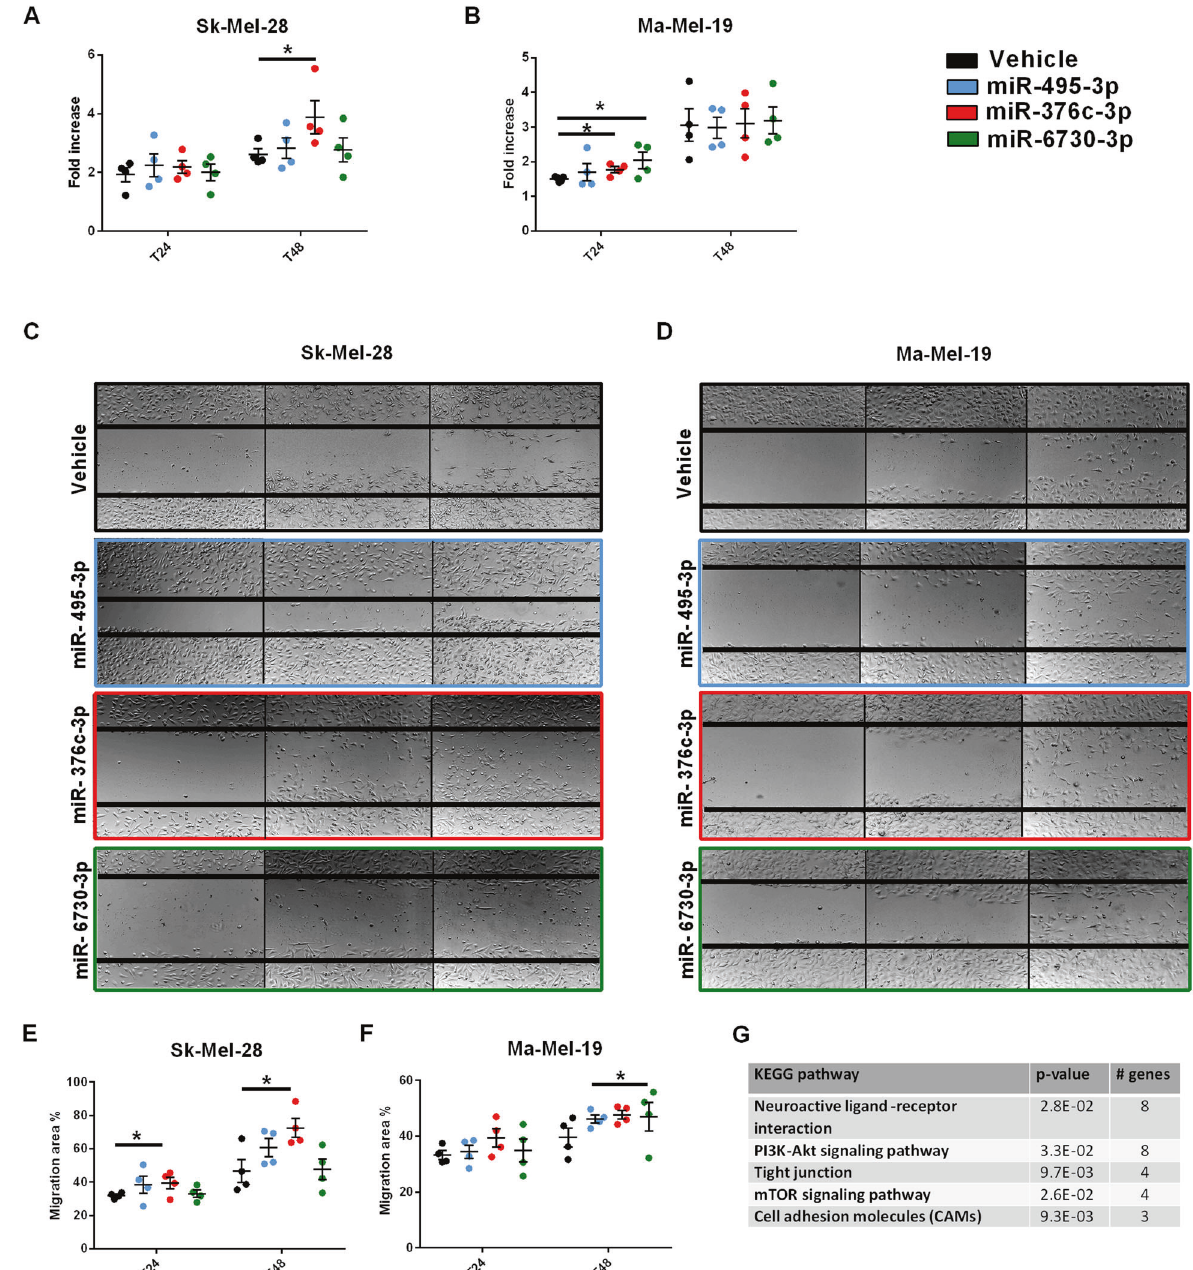
Fig. 8 Effect of miR-495-3p, miR-376c-3p, and miR-6730-3p transfection on proliferation and migration of Sk-Mel-28 and Ma-Mel-19 cells. A Sk-Mel-28 or B Ma-Mel-19 cells were transfected with miRNA mimics for miR-495-3p, miR-376c-3p, miR-6730-3p and scrambled control. Cells were counted for 3 days, starting 24 h after transfection. Data are presented as a fold increase on time 0. C – F Sk-Mel-28 and Ma-Mel-19 cells were transfected with the above-described miRNA mimics or control. The scratch recovery assay was performed starting 24 h after transfection in serum-free medium C Representative images of scratches taken at time 0, 24 and 48 h in Sk-Mel-28. D Representative images of scratches taken at time 0, 24, and 48 h in Ma-Mel-19. E Quanti fi cation of the migratory ability of Sk-Mel-28 cells expressed as the percentage of the migration area evaluated after 24 and 48 h from the scratch formation. F Quanti fi cation of the migratory ability of Ma-Mel-19 cells expressed as the percentage of the migration area assessed after 24 and 48 h from the scratch formation. G Biological pathways regulated by all three tested miRNAs. Data are shown as the mean ± SEM of four independent experiments ( N = 4). * p < 0.05 by Student ’ s t Ultracentrifugation and nanoparticle tracking analysis (Sigma), while ATP and nucleic acids were stained 1 µM Quinacrine Con fl uent cells were incubated in saline solution (see above) with or (Sigma). Images were acquired at 30 s intervals for 15 – 30 min with a Zeiss without 3 mM ATP for 30 min at 37 °C. Cells and debris were removed by LSM 510 microscope after stimulation with 500 µM BzATP. For electron centrifugation at 2000 × g for 20 min at 4 °C. MV fraction was pelleted at microscopy, cells were incubated for 10 min with or without 3 mM ATP, 18,000 × g for 40 min at 4 °C. The remaining supernatant was centrifuged detached from the fl asks with 2 mM EDTA cold PBS, centrifugated at at 100,000 × g for 4 h at 4 °C to obtain EXO. For nanoparticle tracking 1100 rpm, fi xed with 2.5% glutaraldehyde and processed by the Electron analysis, MV and EXO fractions were resuspended in 60 μ l of fi ltered PBS Microscopy Center of the University of Ferrara.